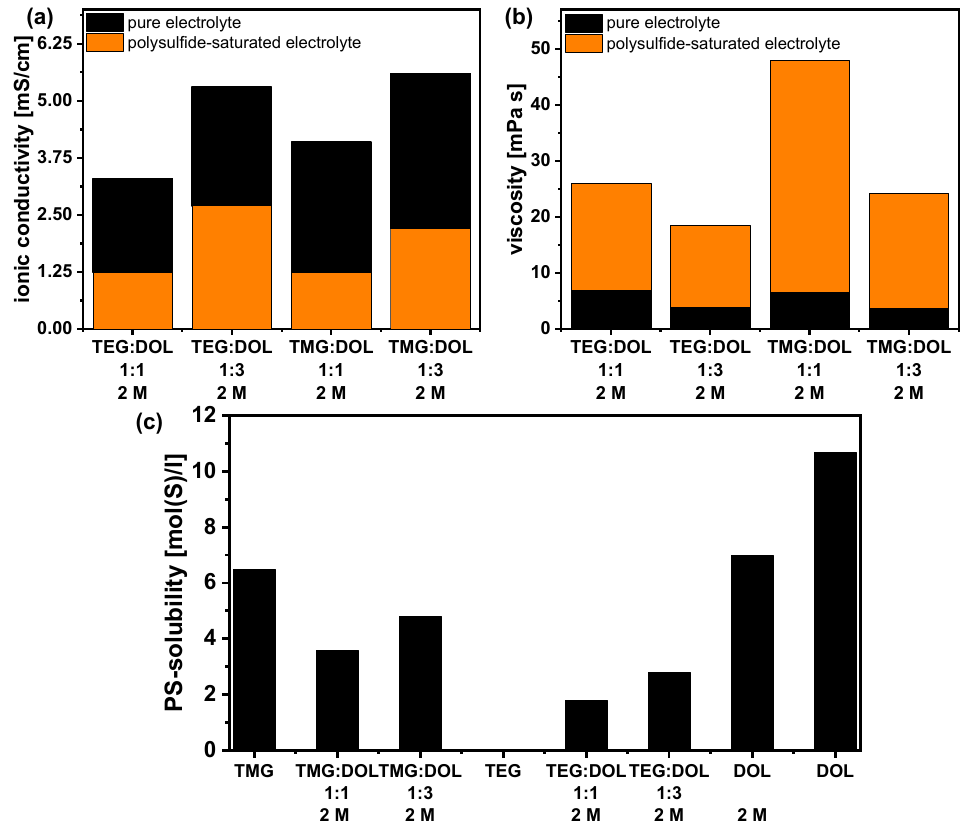
Figure 6. Influence of polysulfides on electrolyte properties at 25 °C: ( a ) ionic conductivities, ( b ) viscosities, ( c ) polysulfide solubility of solvents and electrolytes.